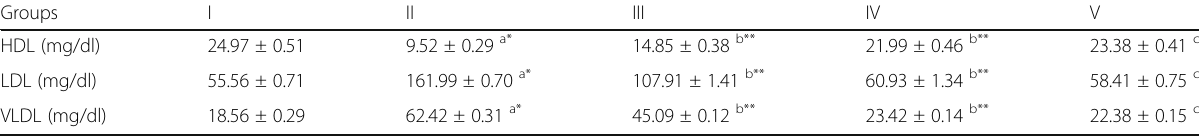
Table 6 Effect of aqueous extract of Caesalpinia bonducella L. on activities of lipoprotein in serum of experimental animals